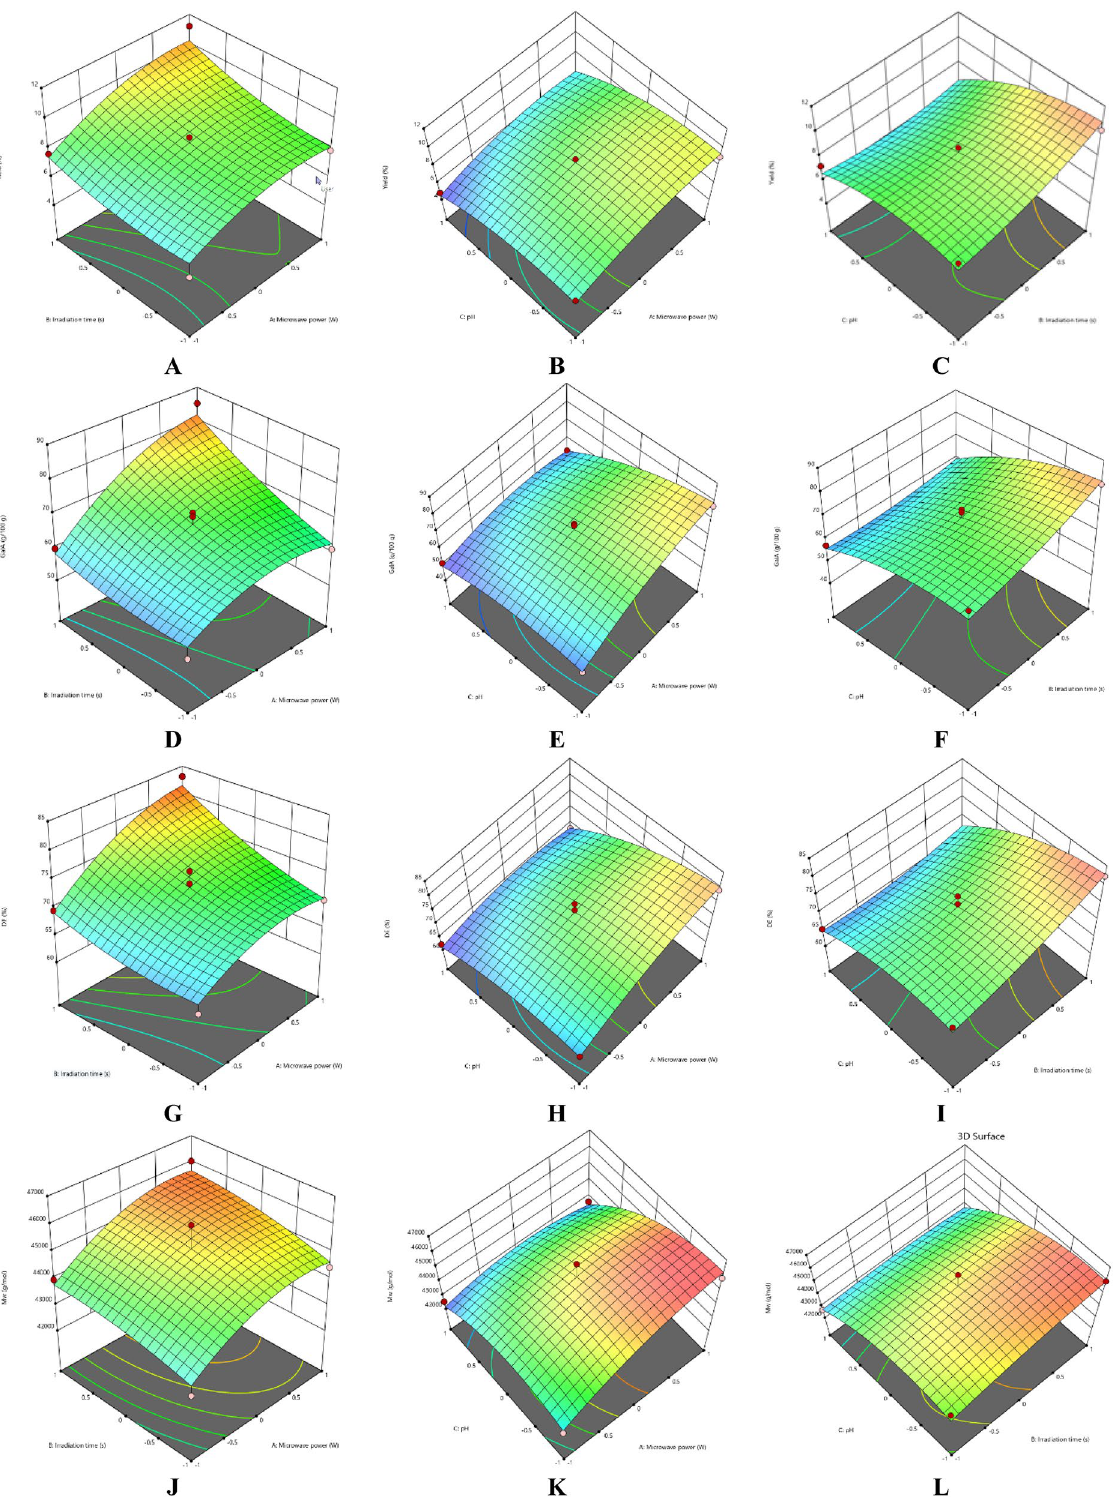
Figure 2. 3D graphs showing the influence of extraction parameters on the yield ( A–C ), GalA content ( D–F ), DE ( G–I ) and M w ( J–L ) for RN